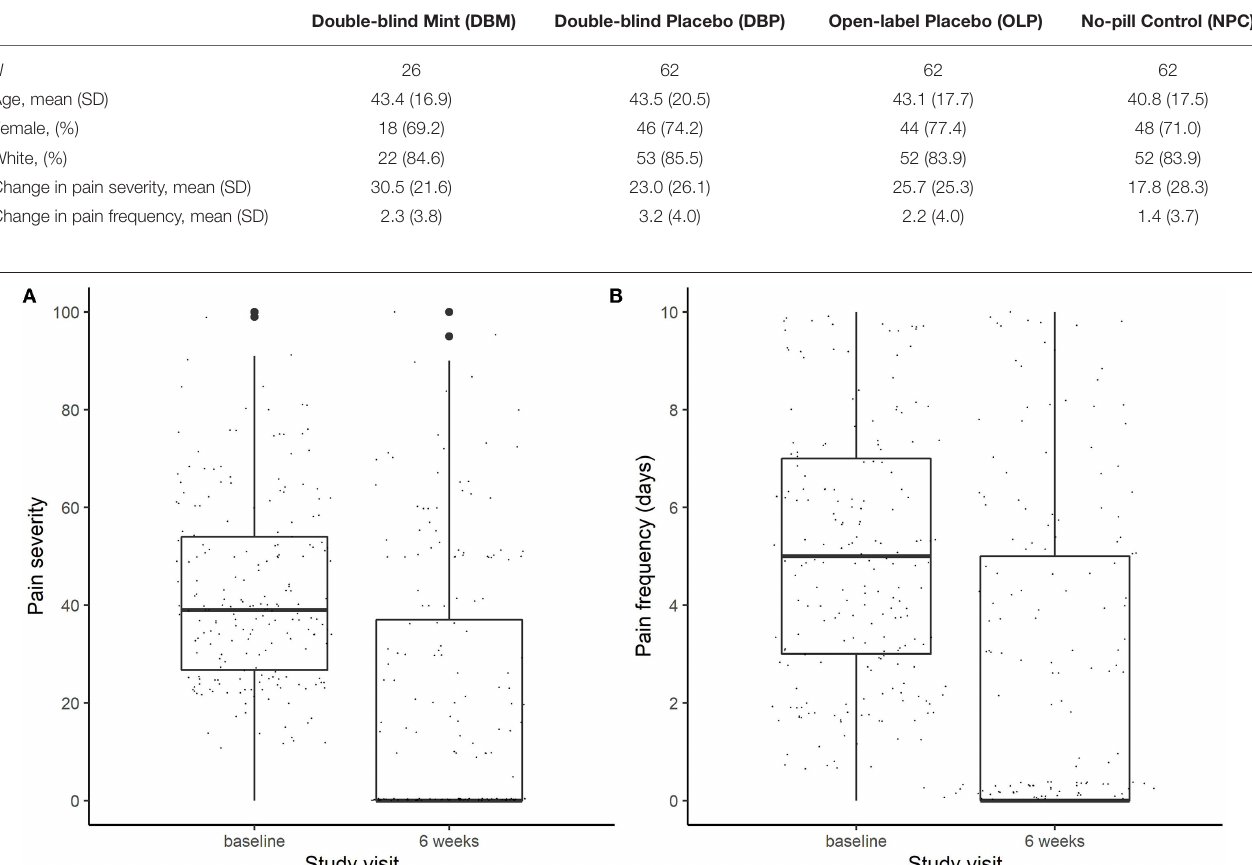
TABLE 1 | Demographics and change in IBS Symptom Severity Score (IBS-SSS) pain severity and pain frequency components by treatment arm. Double-blind Mint (DBM)